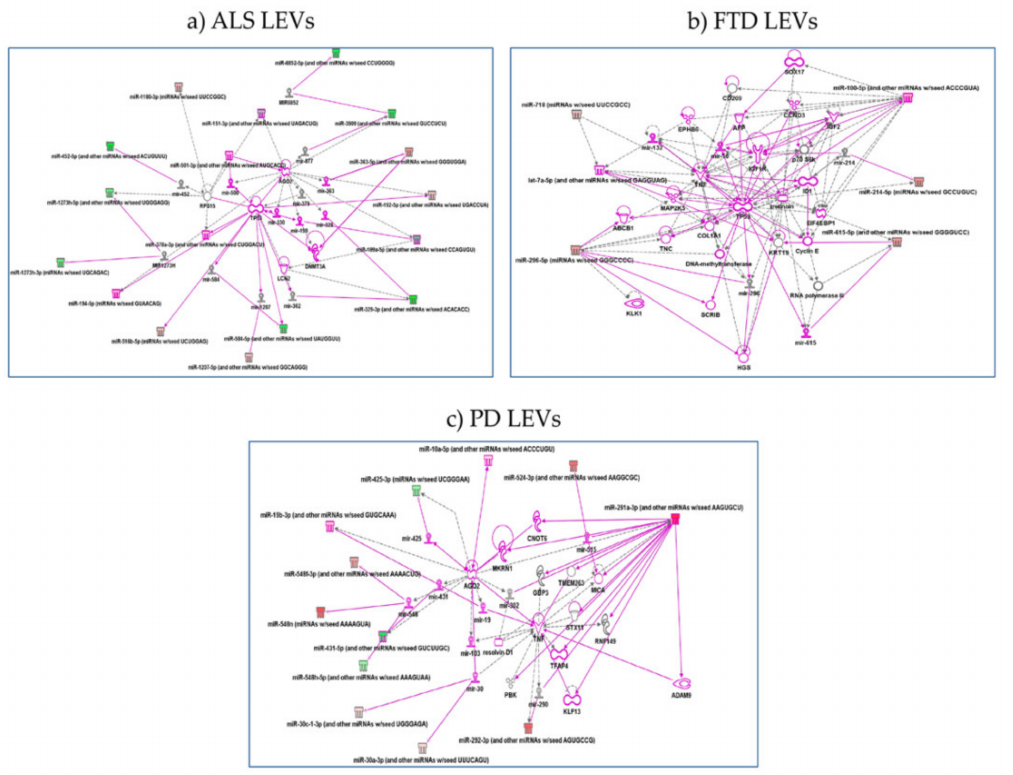
Figure 5. IPA networks among deregulated miRNAs in LEVs from ALS ( a ), FTD ( b ), PD ( c ). ( a ) for ALS, regulation of p53 by mir-379, 378, 584-5p, 1207 emerged or hsa-miR-199a-5p and hsa-miR-329a-5p regulate LCN2, lipocalin2; ( b ) for FTD, regulation of genes like TP53 by miR-296 and RNA Polymerase II by miR-615 as well as Cyclin E regulated miR-615-5p; ( c ) for LEVs from PD patients, regulation of ADAM9 by up-regulation of miR-291. Pink color indicates activation while green color indicate suppression. FTD = Fronto-Temporal Dementia; ALS = Amyotrophic Lateral Sclerosis; PD = Parkinson Disease; LEVs = large extracellular